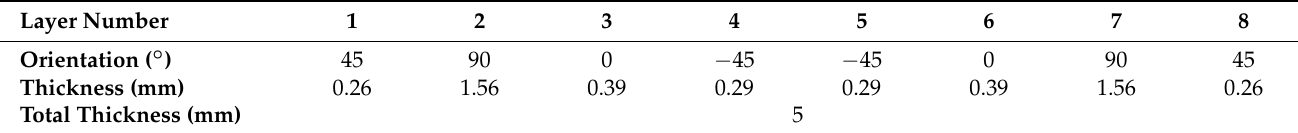
Table 9. Optimal thicknesses of the glass–epoxy plies with their